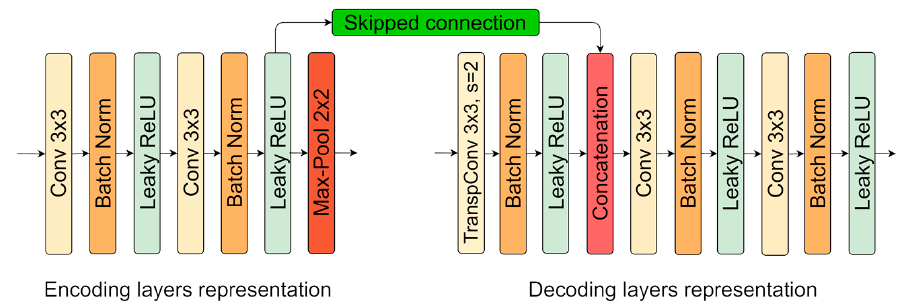
Figure 2. U-Net encoding and decoding layers representations.